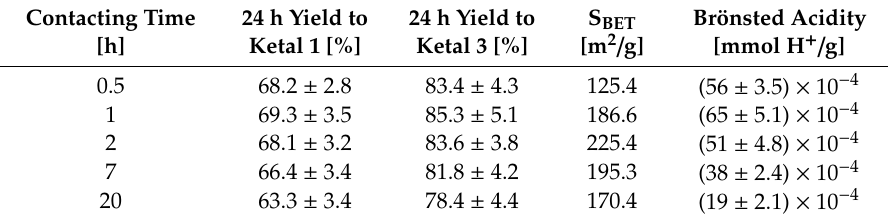
Table 1. Key parameters of the catalysts obtained at several contacting time HCl 3 N-smectite. Contacting Time